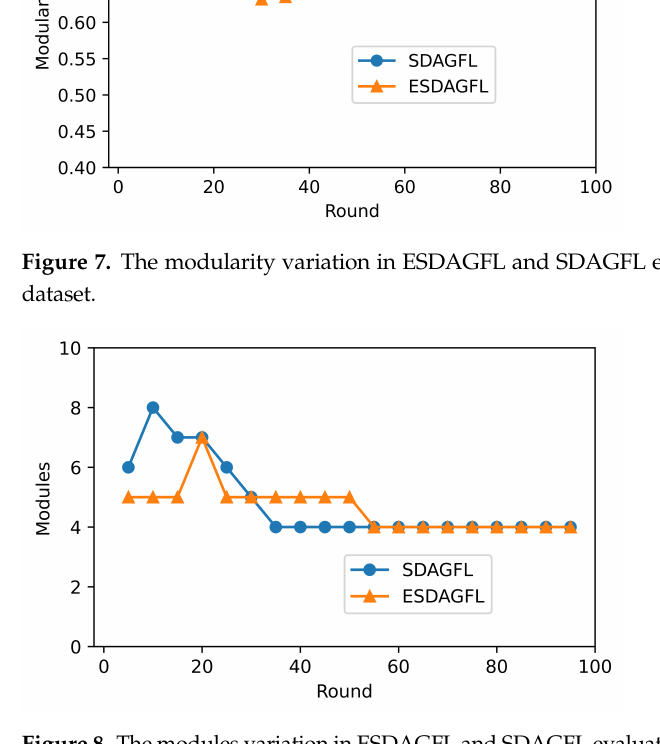
Figure 8. The modules variation in ESDAGFL and SDAGFL evaluated on the FMNIST-clustered dataset. Table 5. Comparison of the approval pureness after 100 rounds of training between ESDAGFL and